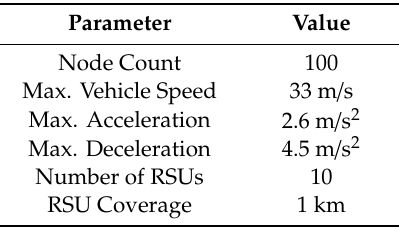
Table 1. Parameter